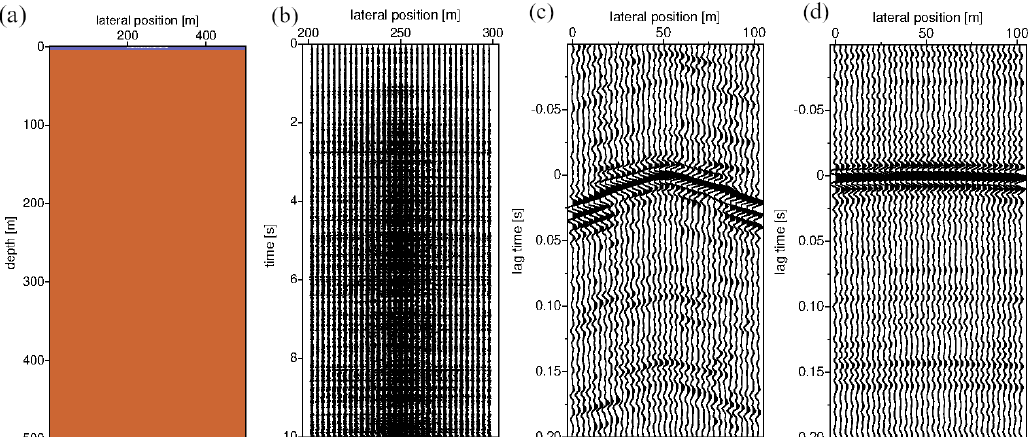
Figure 6. The synthetic layered model (see text for parameter values) (a) , the synthetic drill-bit signal (b) and the synthetic shot gathers with the source positioned at a depth of 9m (c) , and at a depth of 131m (d) . The drill-bit source is represented by 50 sources with random source signatures, starting times and source time